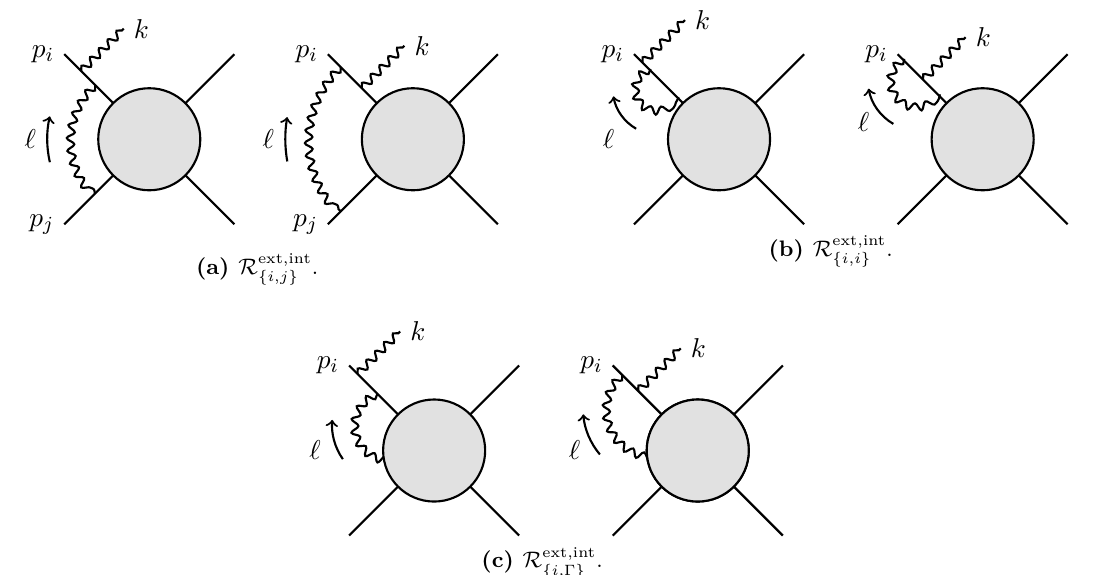
Figure 2 . Diagrammatic classification of the soft contributions each corresponding to a particular momentum routing of a Feynman